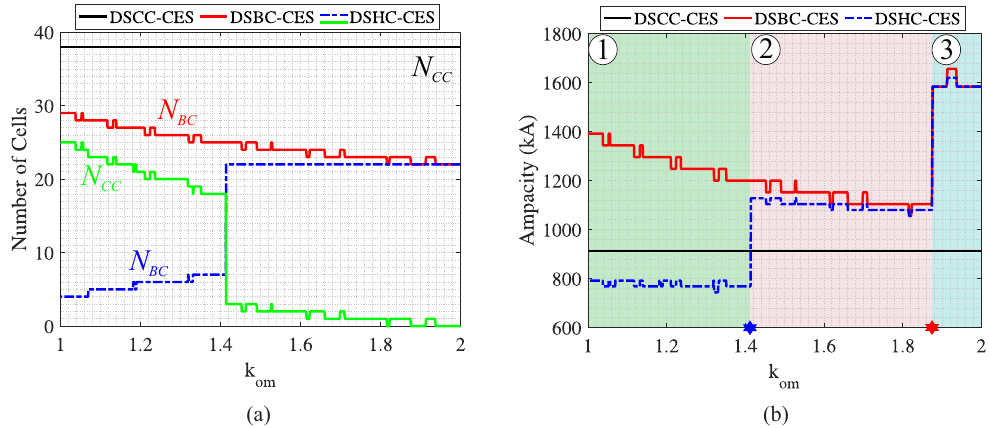
Figure 7. Effect of the over-modulation factor on the performances of CES topologies: ( a ) Number of cells. ( b ) Converter